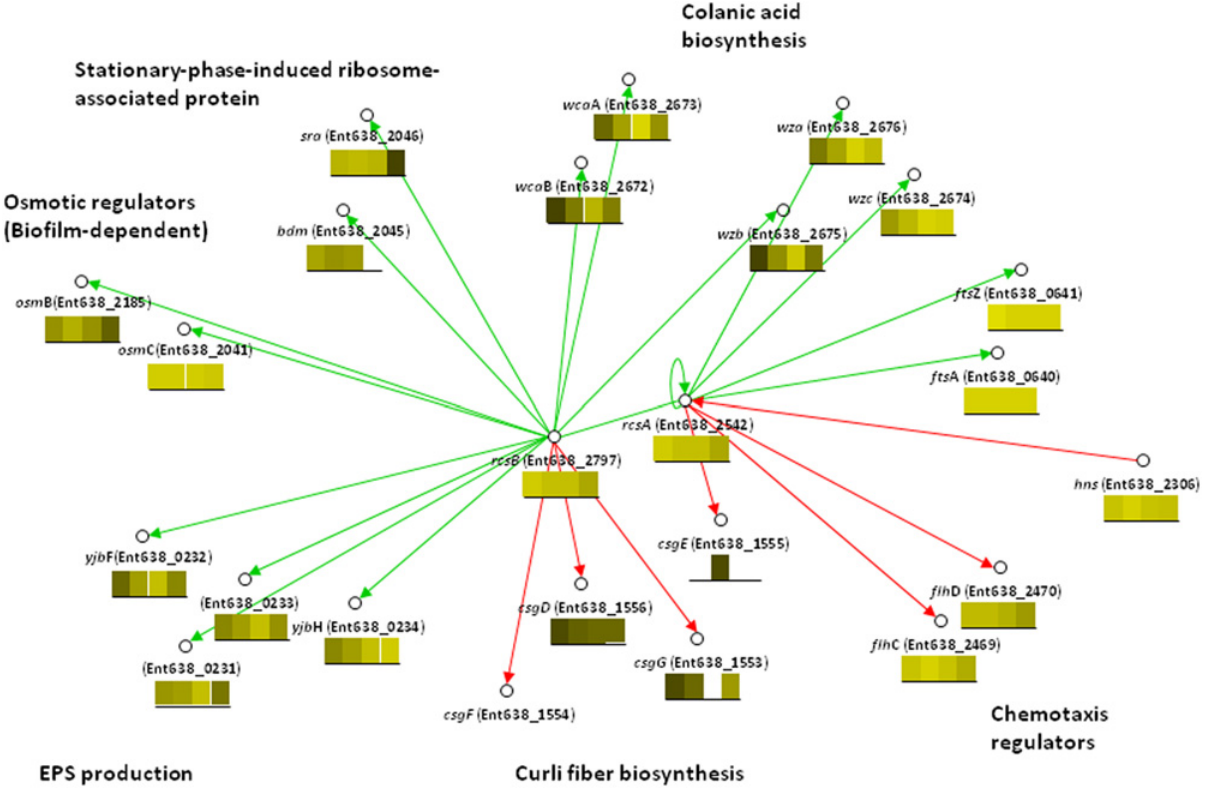
Figure 4. The RcsAB regulatory network in Enterobacter sp. 638. In this regulatory network, genes (nodes), gene-gene interactions (edges) and sign of regulation (color of edges: green-activation, red-repression) are projected from regulatory interactions among orthologs in E. coli K-12 in RegulonDB v7.5, and were implied from RegulonDB. The blocks under each gene represent its experimentally measured expression levels under the four conditions tested: L6, L12, S6 and S12, corresponding to 6 and 12 hours of growth on lactate and sucrose, respectively. Brighter colors indicate higher expression levels; a blank block indicates that no expression was observed. The figure was generated using VistaClara plugin (1.05) in Cytoscape